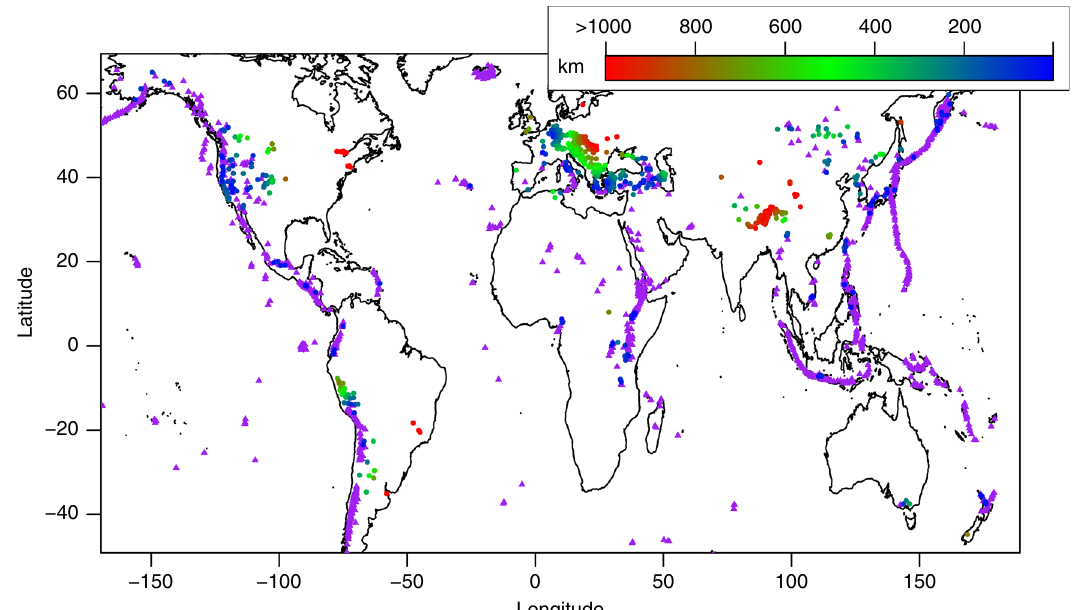
Fig. 5 Volcanic in fl uence on earth degassing. World map of Holocene volcanoes (purple triangles) and gas discharged (circle) colored in function of the distance from the closest holocene